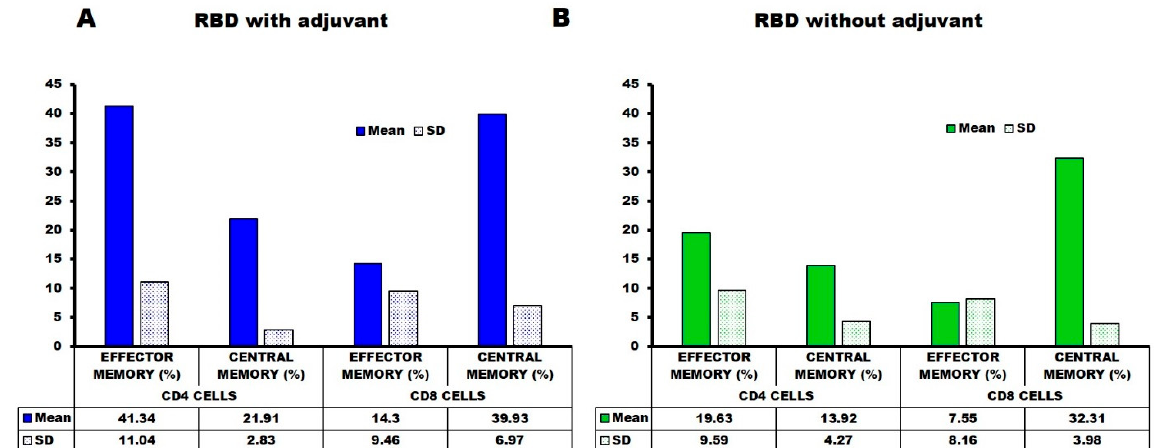
Figure 6. The relative percentages of co-expression of CD44 and CD62L on CD4+ and CD8+ cells are shown in panels, respectively. The results were averaged for two mice and the percentage was indicated as mean ± SD.